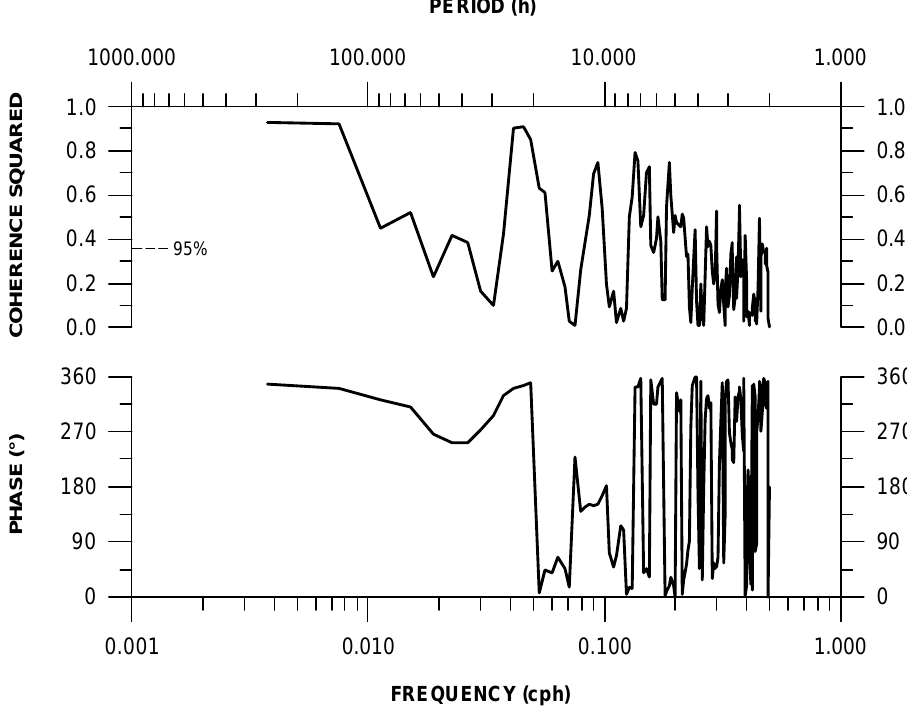
Fig. 7. Coherence squared and phase difference spectra of residual sea levels in Rovinj (input) and Dubrovnik (output).